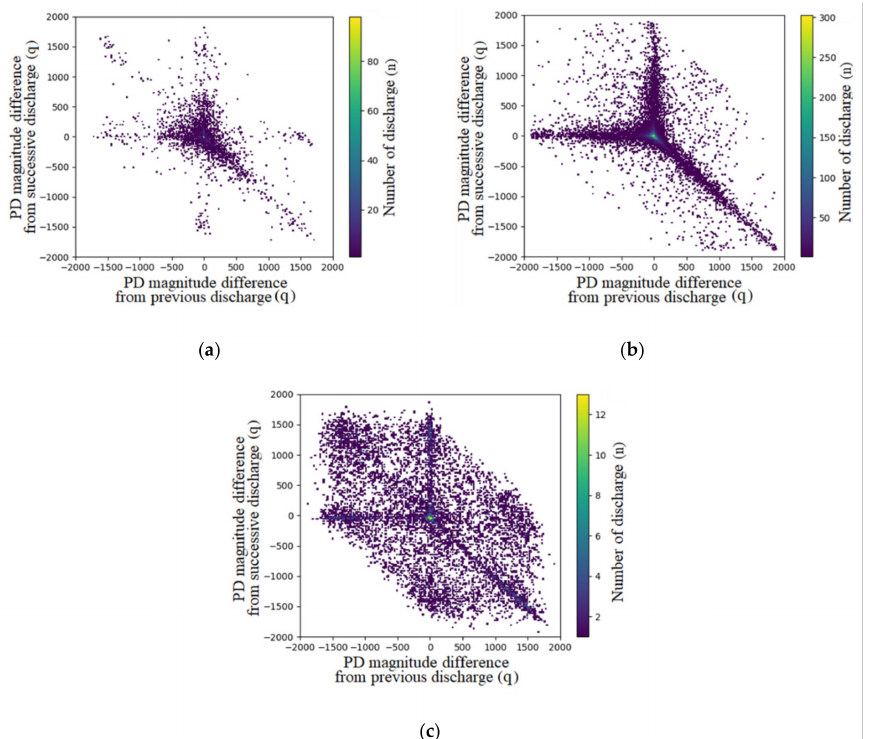
Figure 12. DC void discharge patterns in the discharge colony classified as void discharge due to insulation aging of MI-PPLP through TF mapping: ( a ) beginning of insulation aging; ( b ) middle of insulation aging; ( c ) period before the dielectric breakdown.